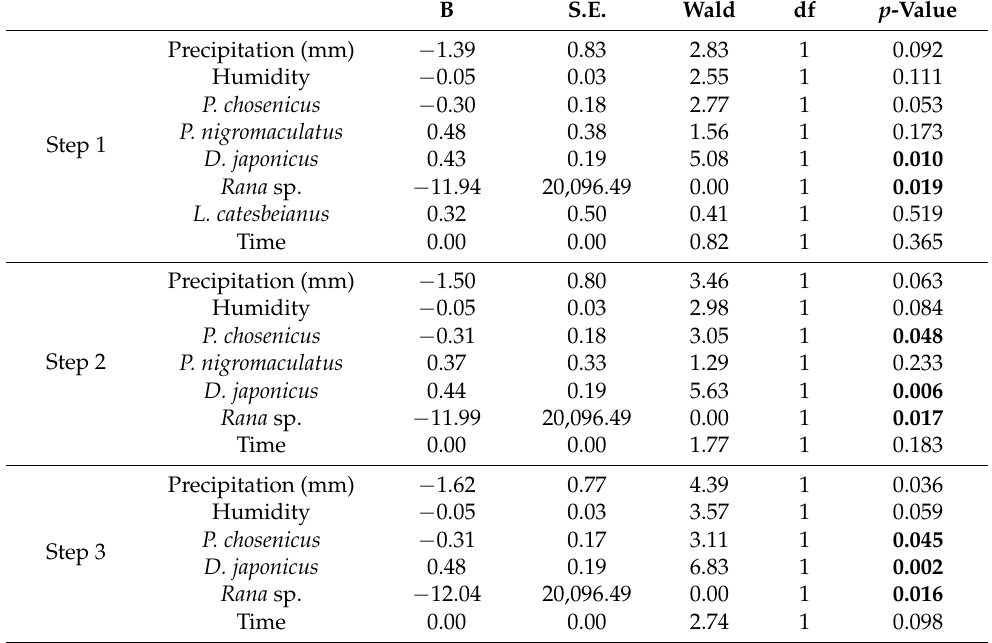
Table 2. Results of the Binary Logistic Regression used to test for the presence or absence of the five amphibian species in concrete vs. natural ditches. The five species were Pelophylax nigromaculatus , P. chosenicus , Dryophytes japonicus , Rana sp. and Lithobates catesbeianus and the surveys were conducted in central Korea in spring